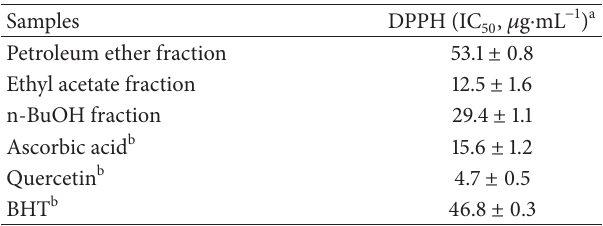
Table 1: Antioxidant activities of different fractions from Selaginella doederleinii in DPPH assay.